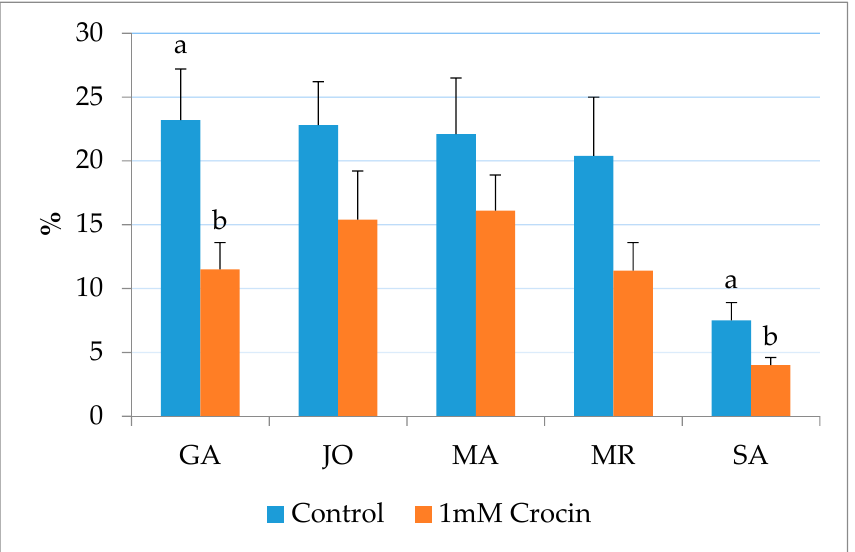
Figure 1. Percentages of Tunel-positive sperm (DNA fragmentation index) of frozen-thawed goat sperm in different breeds: Garganica (GA), Jonica (JO), Maltese (MA), Mediterranean Red (MR) and Saanen (SA) between 0 mM (control) and 1 mM crocin groups. a,b Bars with different letters are significantly different; p < 0.05.